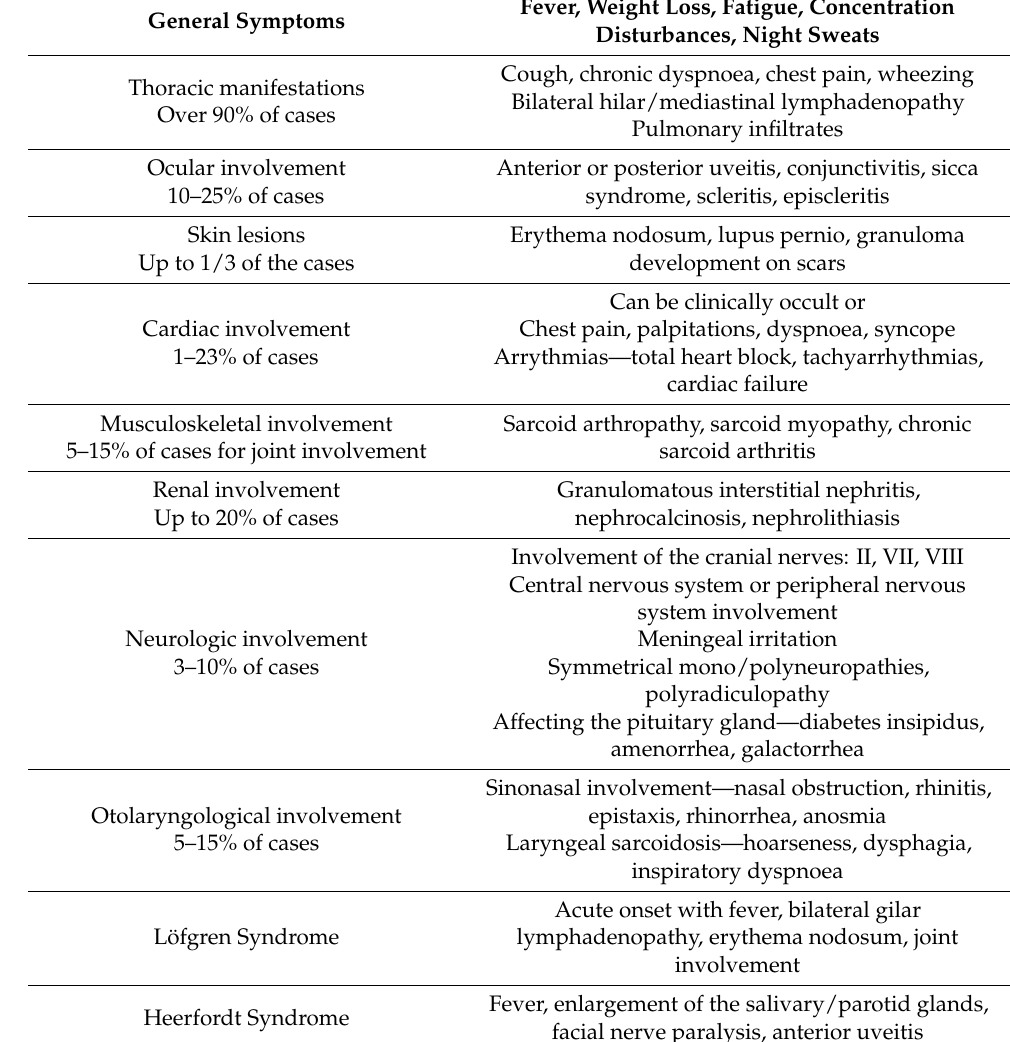
Table 1. Organ involvement and symptoms of sarcoidosis